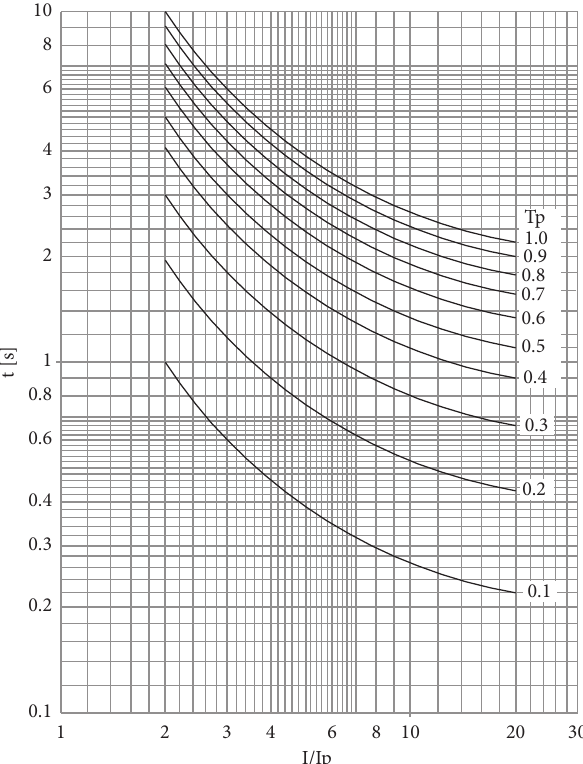
Figure 5: Time and PSM curves, normal inverse acc. to IEC [17].